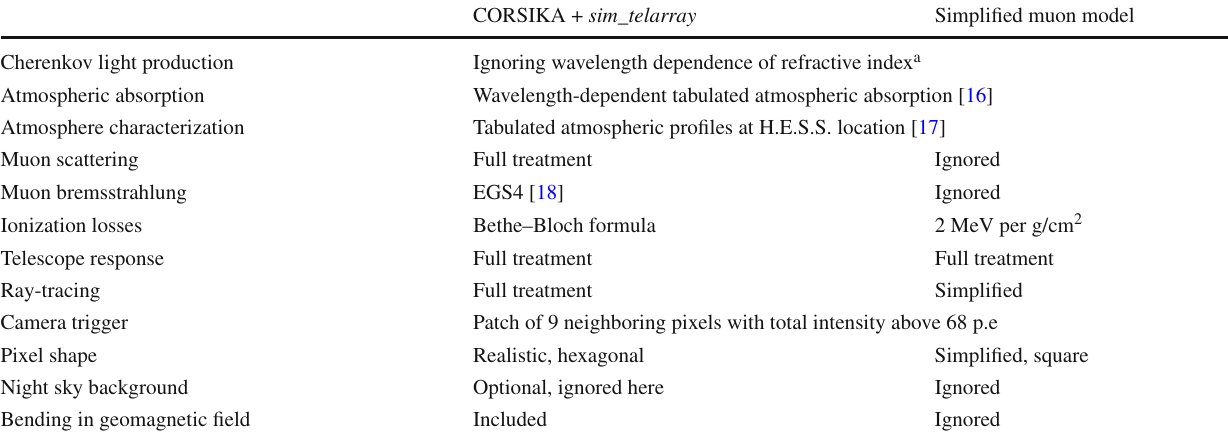
Table 1 Comparison of muon treatment between the CORSIKA+ sim_telarray approach and the simplified muon